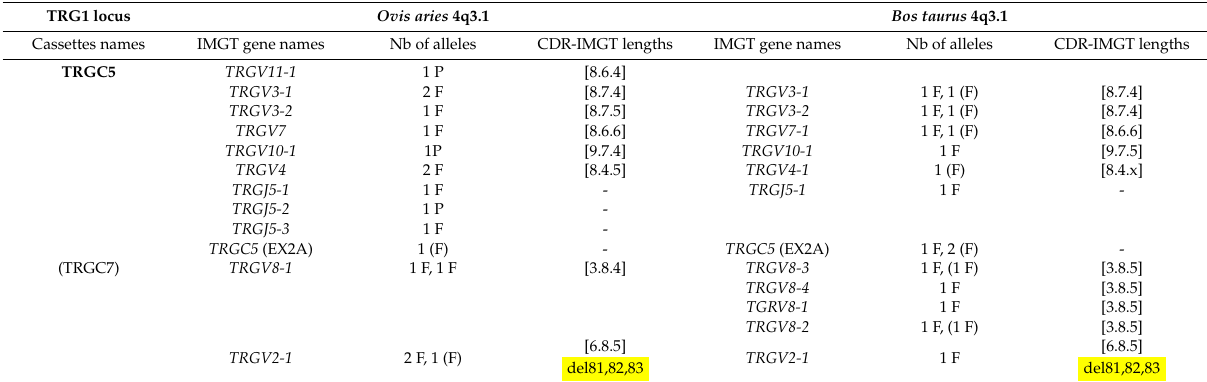
Table 3. Cassette comparison between Ovis aries and Bos taurus . Ovis aries